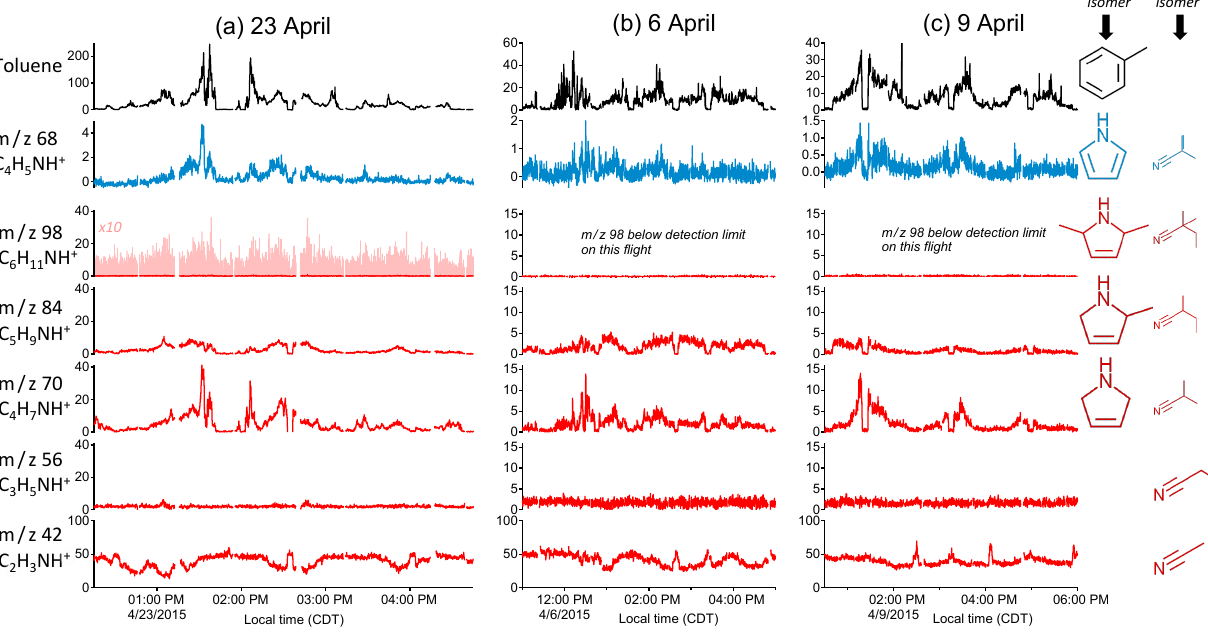
Figure 13. Time series of the homologous series of nitrogen-containing masses C n H 2 n − 1 NH + from n = 2 to n = 6 during the Permian Basin flights on 23, 6, and 9 April. Toluene and pyrrole are also shown. The y axis is in units of normalized counts per second (instrument signal) for all ion masses (including toluene, C 7 H 8 H + ) . Ten-second box averages of all species are shown for clarity. Data collected during vertical profiles are included in these time series, to show low concentrations outside of the boundary layer. Right: some possible isomers for each mass. An example of a cyclic structure is given in the left column, and an example of a non-cyclic structure in the right column.